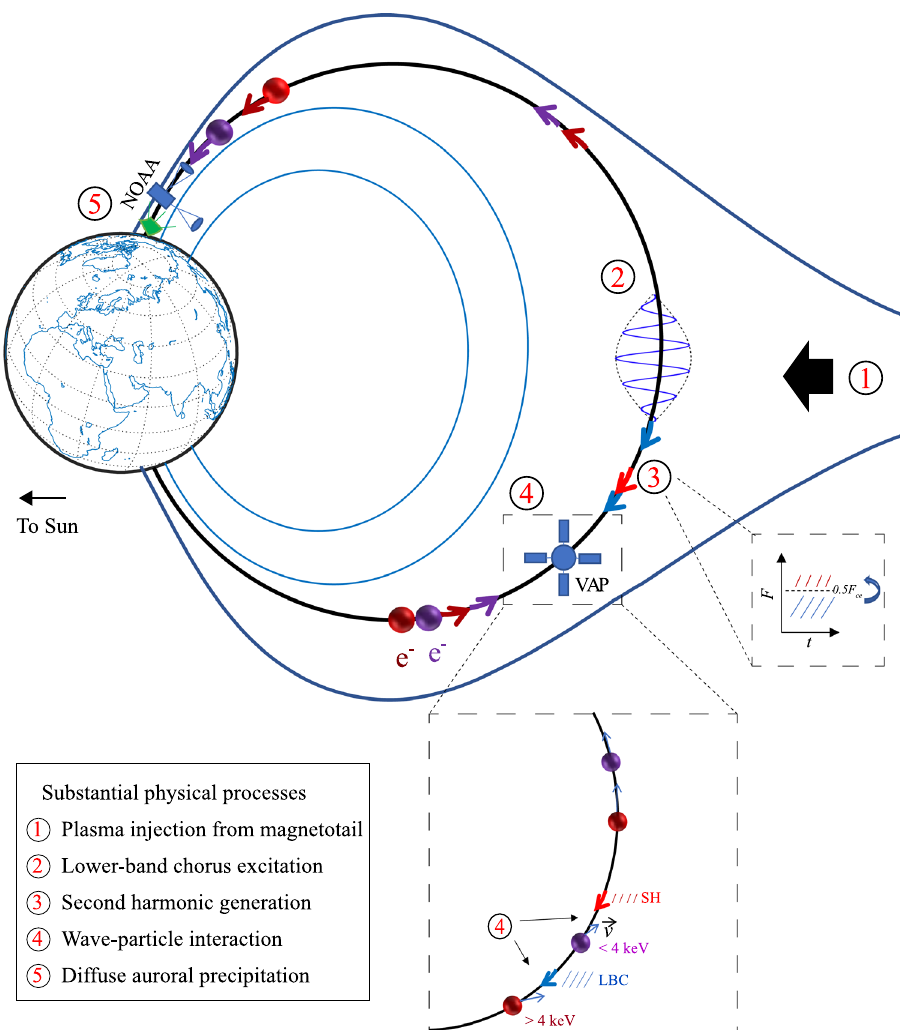
precipitationsbothaboveandbelow4keVtoformdiffuseaurora(step5,observed by the National Oceanic and Atmospheric Administration Polar Orbiting Environ- mentalSatellite,NOAA).Ballswithbrightredcolorsdenoteelectronswithenergies >4keV while those with dark red colors are below